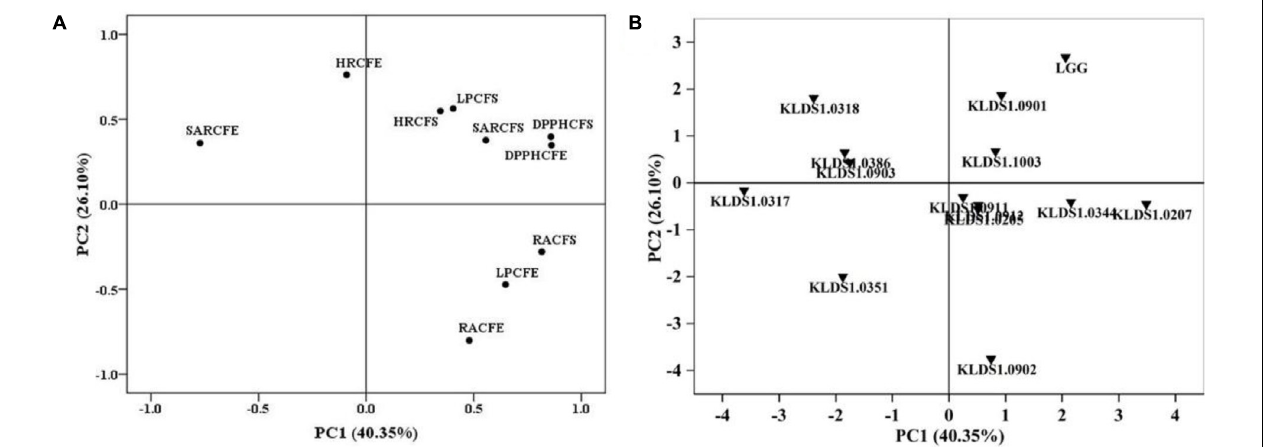
FIGURE 1 | Loading and score plots of principal component analysis. (A) Loading plot for results of five different antioxidant assays. RACFS (CFE), reducing activity of cell-free supernatant (CFS) [cell-free extract (CFE)]; DPPH CFS (CFE), 1,1-diphenyl-2-picryl-hydrazyl (DPPH)-scavenging activity of CFS (CFE); HRCFS (CFE), hydroxyl radical-scavenging activity of CFS (CFE); SARCFS (CFE), superoxide anion radical-scavenging activity of CFS (CFE); LPCFS (CFE), lipid peroxidation inhibition capacity of CFS (CFE). (B) Score plot of the antioxidative properties of Lactobacillus strains. PC1, first principal component; PC2, second principal component.